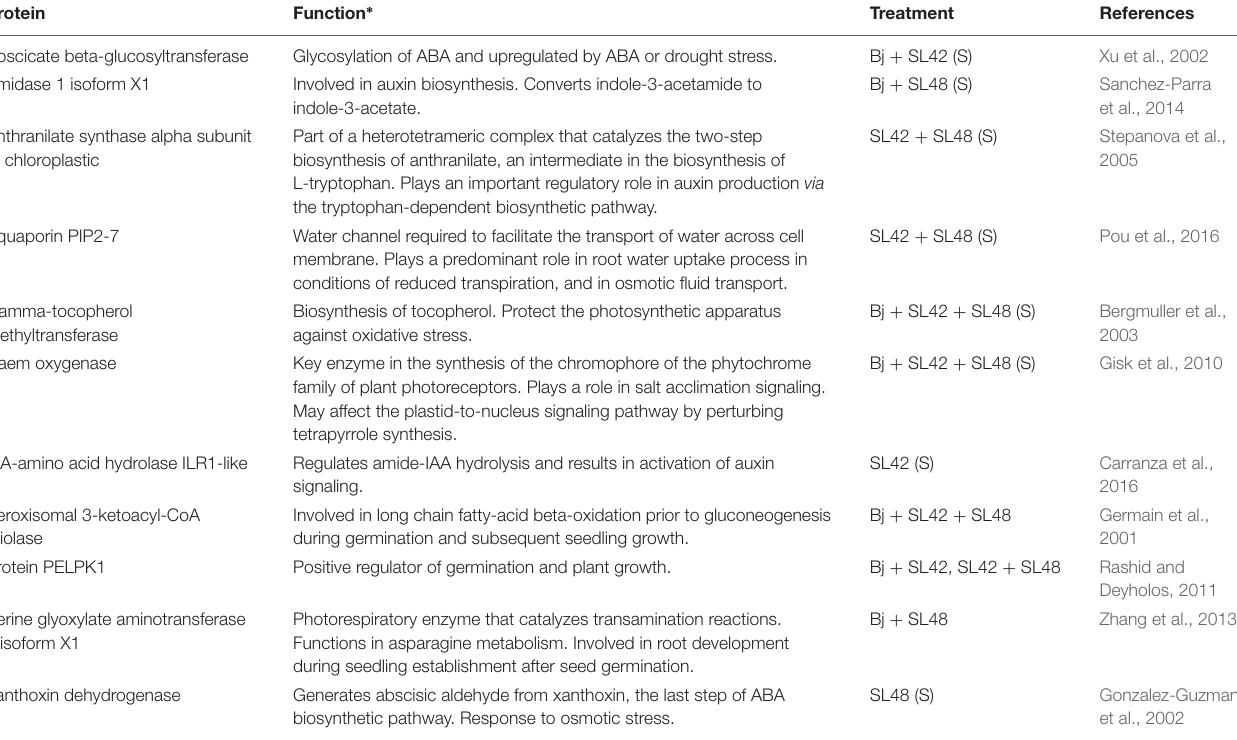
TABLE 3 | Upregulated proteins involved in phytohormone-mediated responses.